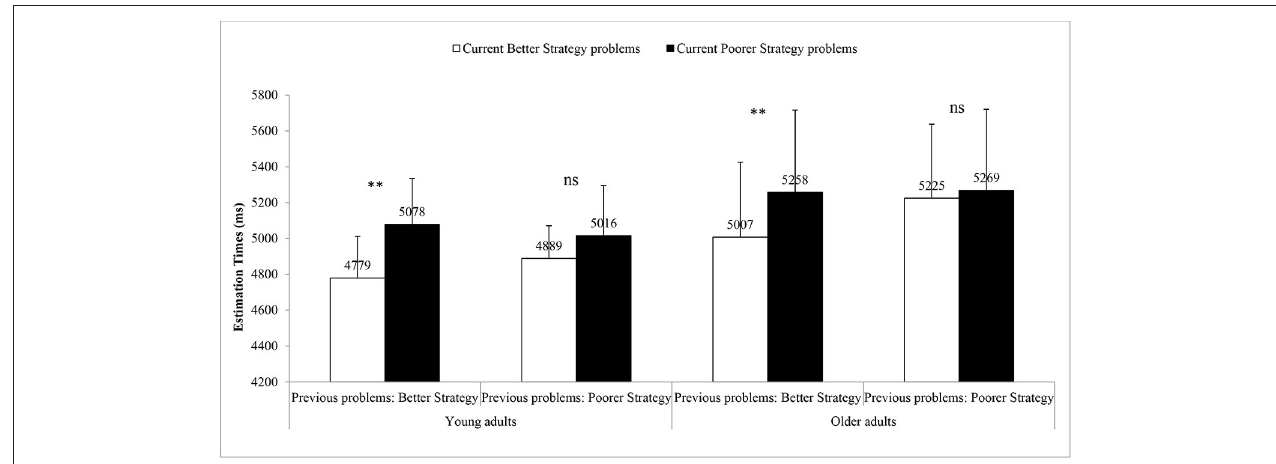
FIGURE 2 | Mean solution times for current better strategy and poorer strategy problems following better strategy or poorer strategy problems in young and older adults. Error bars represent S.E.M. ** p < .01, ns, non-significant.